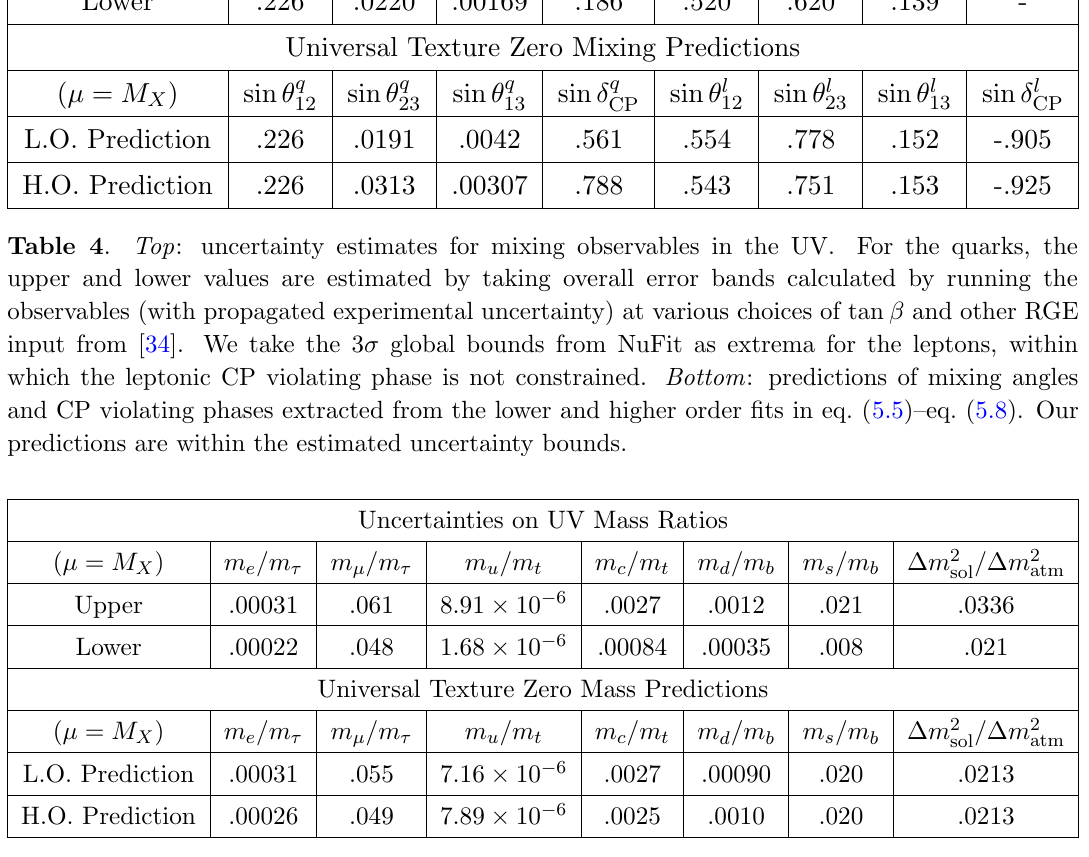
Table 5 . Top : uncertainty estimates for mass ratios in the UV. Bounds for the quarks are again taken from the running calculated in [34] which includes a propagated experimental uncertainty, without assuming speci(cid:12)c RGE input. We estimate the neutrino mass squared di(cid:11)erence in the UV from [47]. Bottom : predictions of mass ratios obtained from the numerical (cid:12)ts described in the text, both including (H.O.) and not including (L.O.) a higher order operator. It is again clear that our predictions (cid:12)t well within the uncertainty